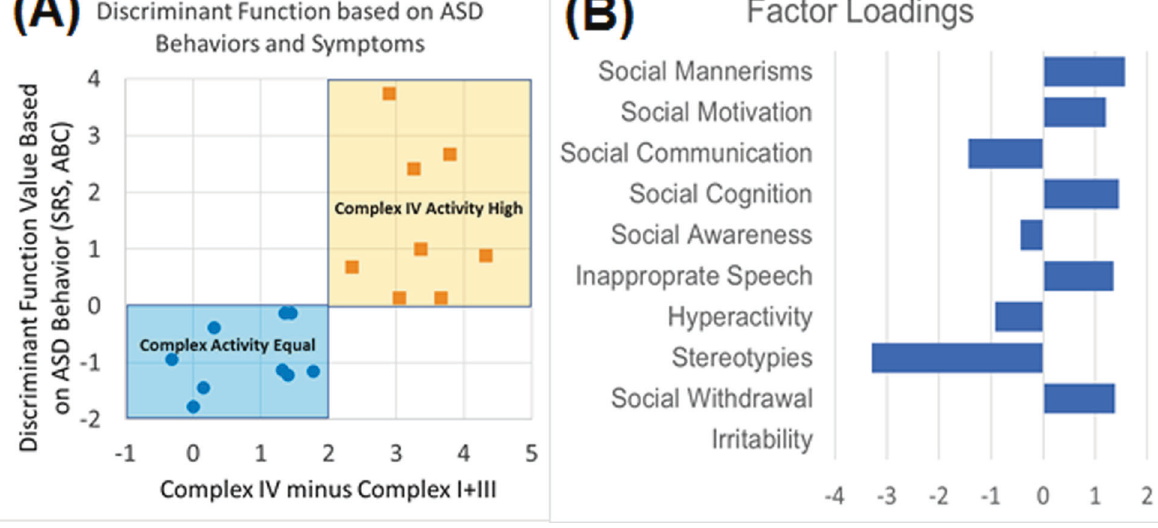
Fig. 8 The Discriminant Function developed from scales of ASD symptoms and behavior. A Function separates ASD individuals into the two mitochondrial activity subgroups. B Loadings (in fl uence) of individual ASD symptom and behavior